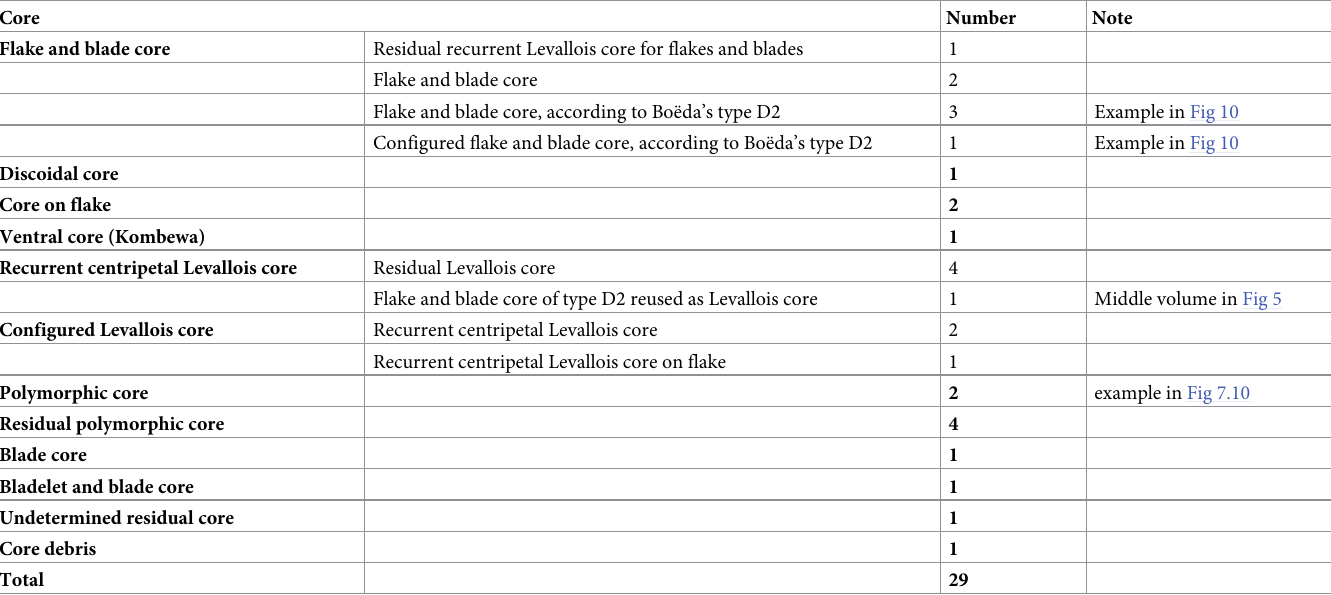
Table 2. List of cores at